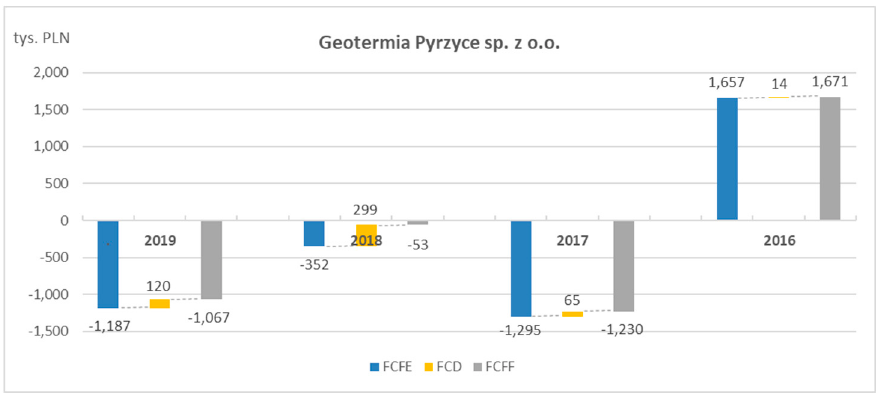
Figure 8. Formation of FCFE, FCD and FCFF in Geotermia Pyrzyce Sp. z o.o. Source: Own study on the basis of: [54].